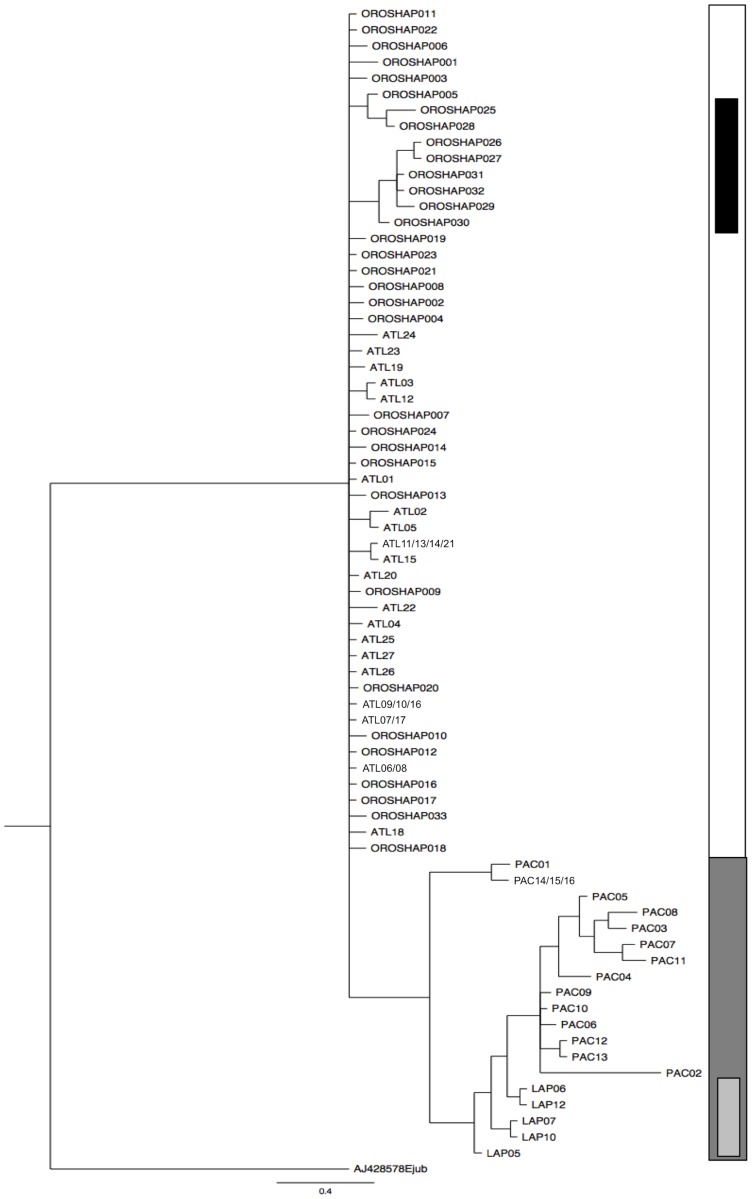
Phylogenetic tree of mtDNA control region haplotypes identified in this study and by Lindqvist et al. [2].Samples from LAP, PAC, ATL and MAR are shown highlighted by light gray, dark gray, white, and black, respectively. The Stellar sea lion (Eumetopias jubatus) is used as an outgroup.